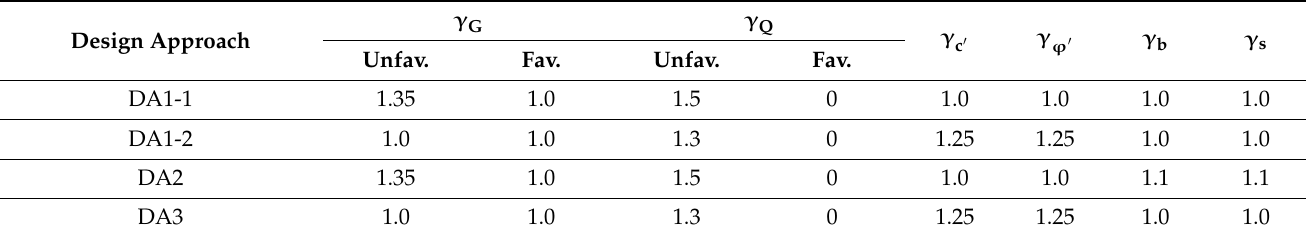
Table 3. Partial factors for geotechnical Ultimate Limit